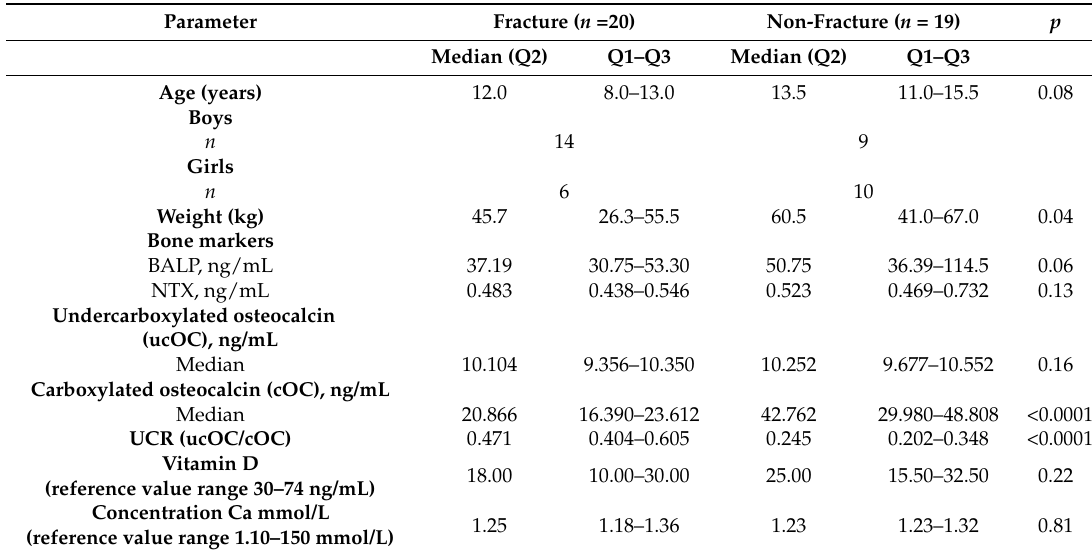
Table 1. Demographic and anthropometric data, bone markers, and vitamin K parameters of children with fracture and